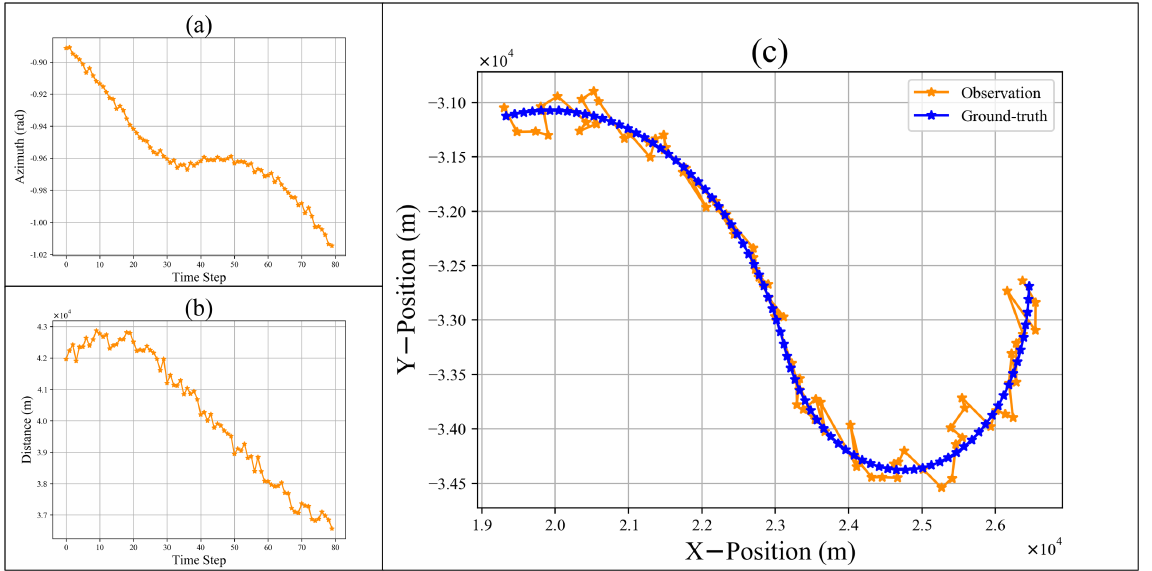
Figure 1. The observation and ground-truth of a trajectory. The ( a ) is the azimuth observation sequence of the trajectory. The ( b ) is the distance observation sequence of the trajectory. The ( c ) is the observation and ground-truth sequence in the X-Y plane coordinate system.